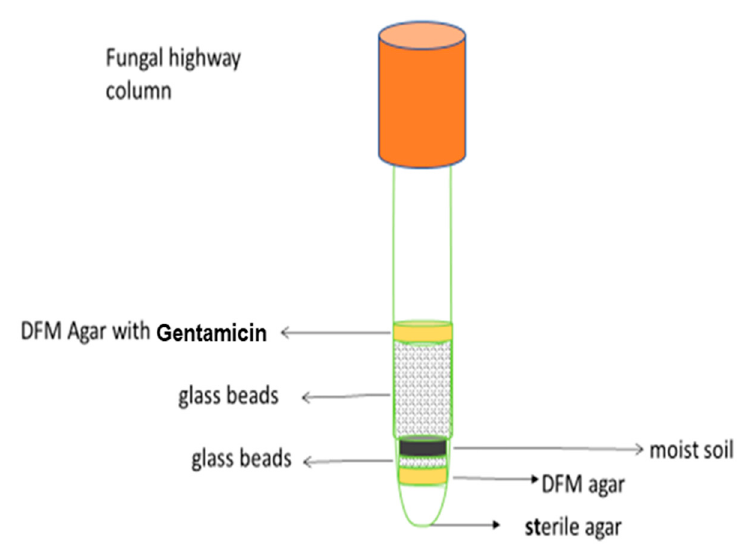
facultative endohyphal